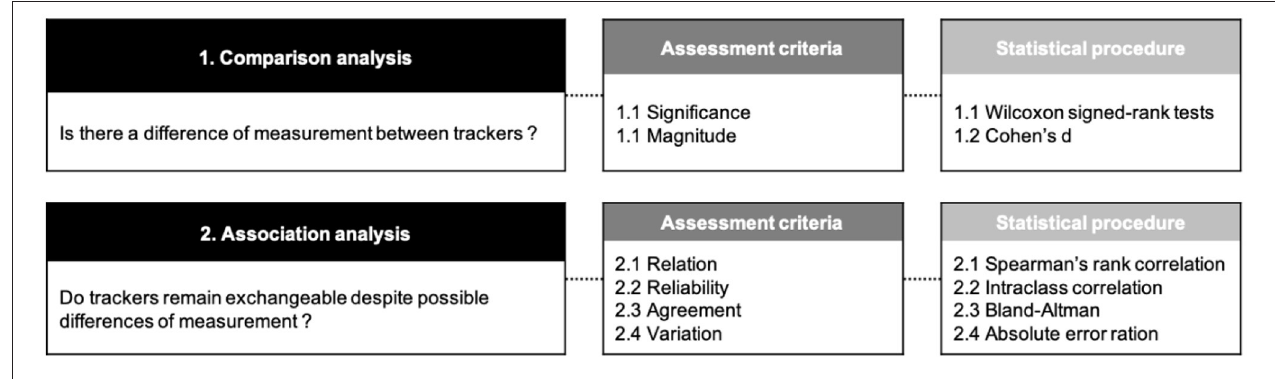
FIGURE 1 | Synthesis diagram of the statistical treatment.